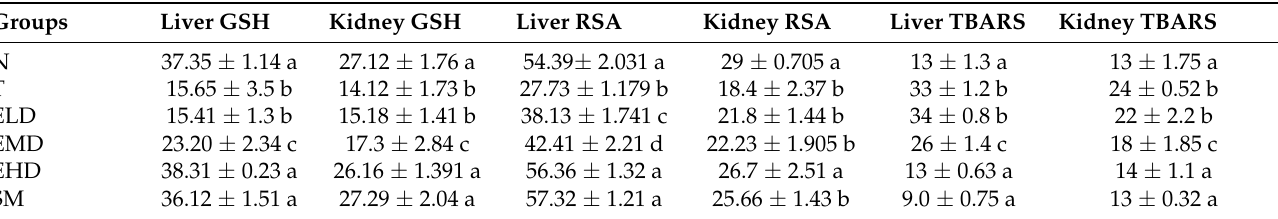
Table 6. Liver and kidney antioxidant markers of various experimental